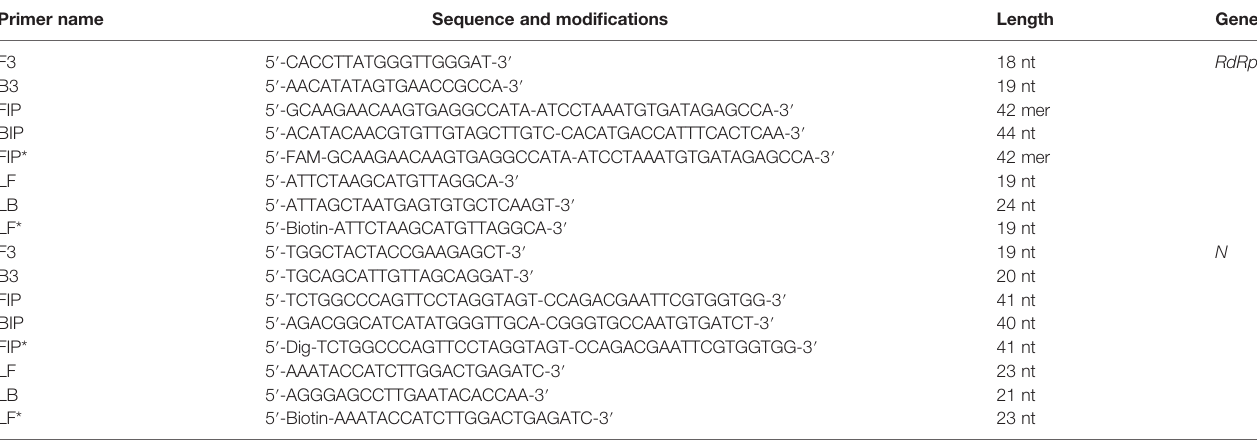
TABLE 1 | The primers used in the present